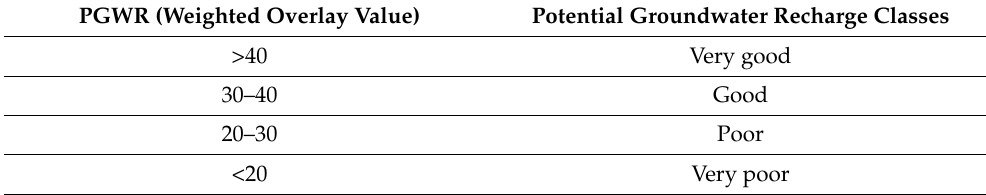
Table 3. Potential groundwater recharge classes.